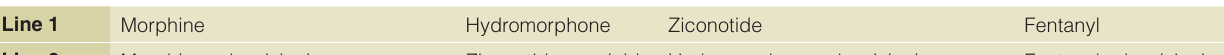
Table 4. 2012 polyanalgesic algorithm for intrathecal (IT) therapies in nociceptive pain 7 . Line